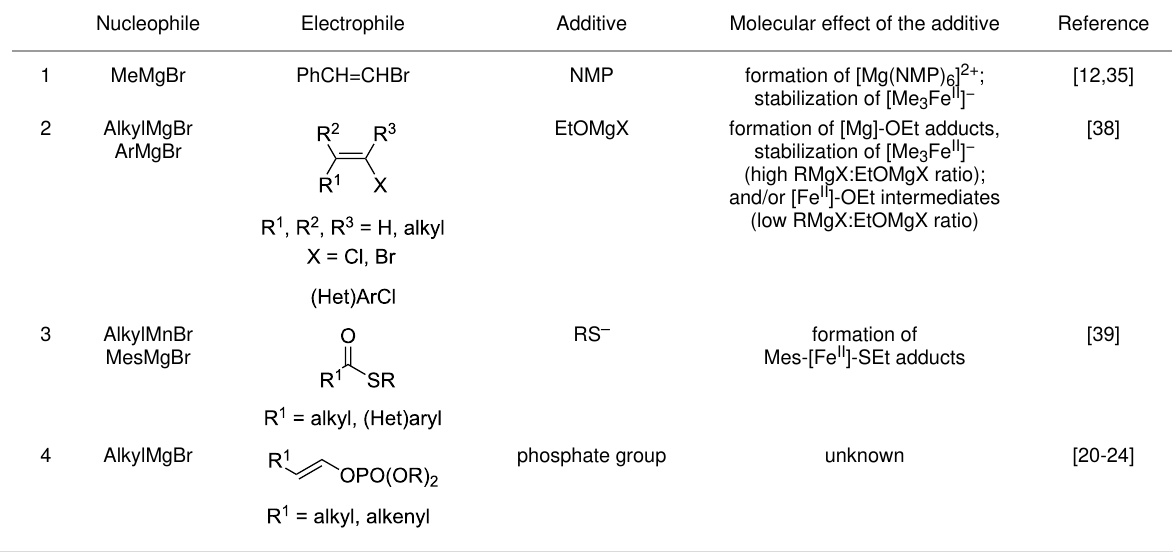
Table 2: Selected additives used in iron-mediated cross-coupling procedures and their role at a molecular level. Nucleophile Electrophile Additive Molecular effect of the additive